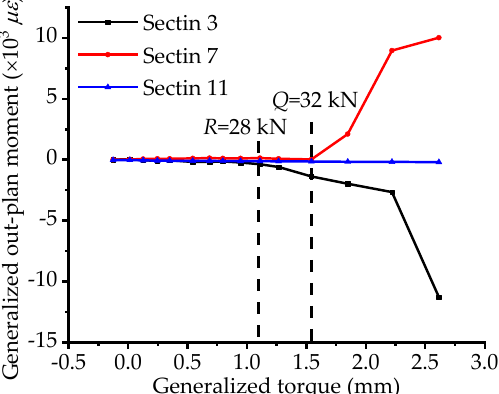
Figure 13. The correlation between torque and out-plan bending moment.